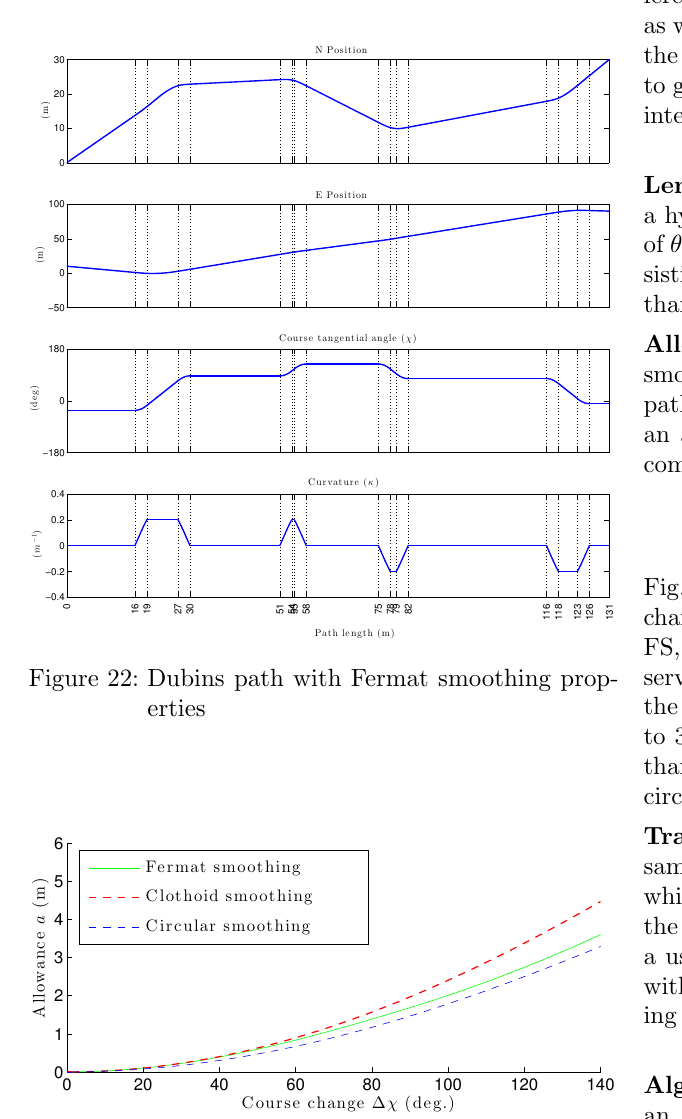
Figure 23: Fermat, clothoid and circular smoothing al- lowance